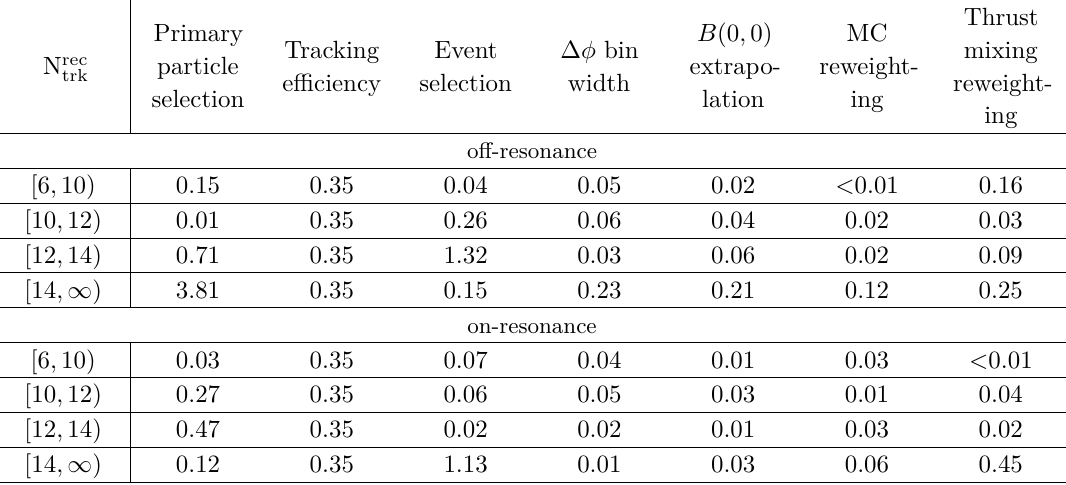
Table 4. Thrust axis analysis systematic uncertainties for the off-resonance and on-resonance data as a function of the reconstructed-track multiplicity N rec the long-range differential associated